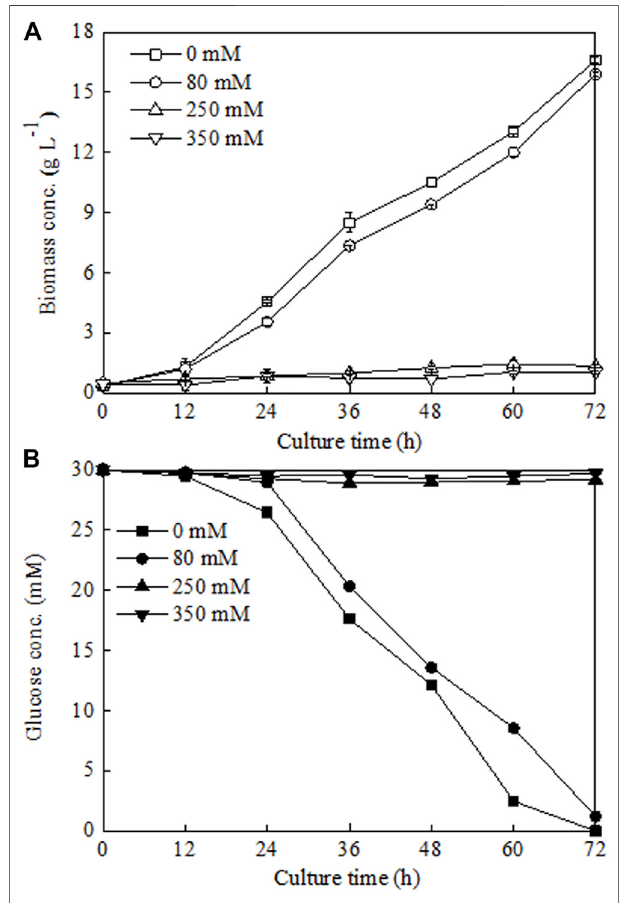
FIGURE 5 | Comparison of biomass growth (A) and glucose consumption (B) underdifferentsodiumchlorideadditionamounts.Valuesare shown as mean ± SD from three biological independent